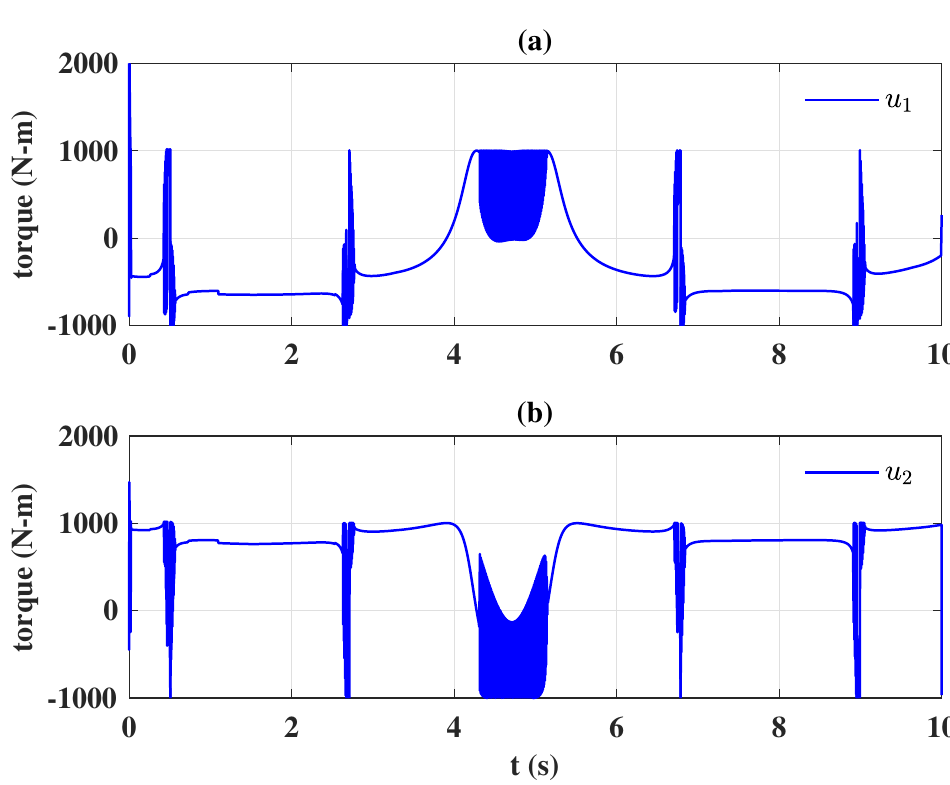
Figure 2. Time history of control signals ( a ) u 1 and ( b ) u 2 .